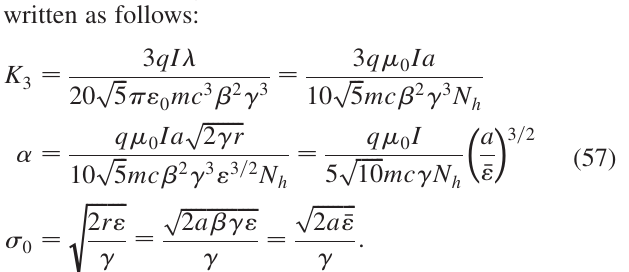
p ffiffiffiffiffiffiffiffiffiffiffiffiffiffiffiffiffiffiffiffiffiffiffi h 1 (cid:1) 4 K=k x